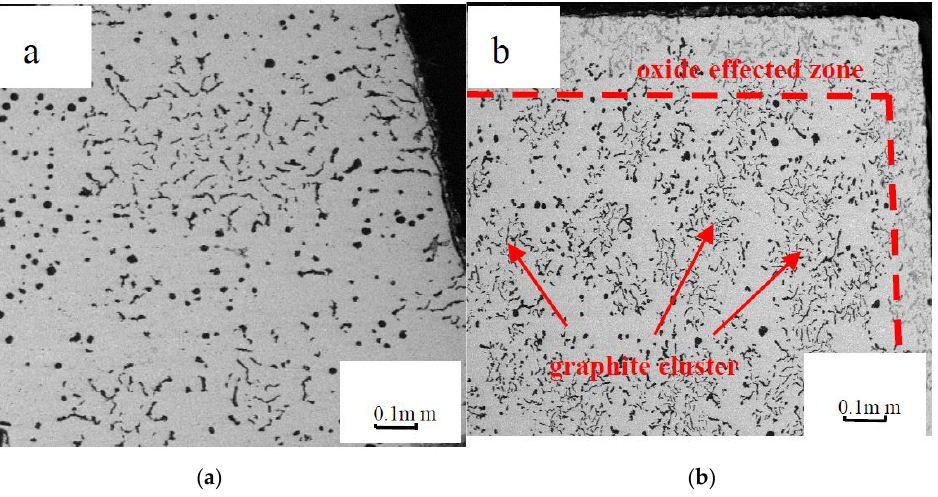
Figure 1. The surface morphology of vermicular graphite iron (vermicular graphite rate is 89%). ( a ) Before oxidation; ( b ) after oxidation for 500 h.